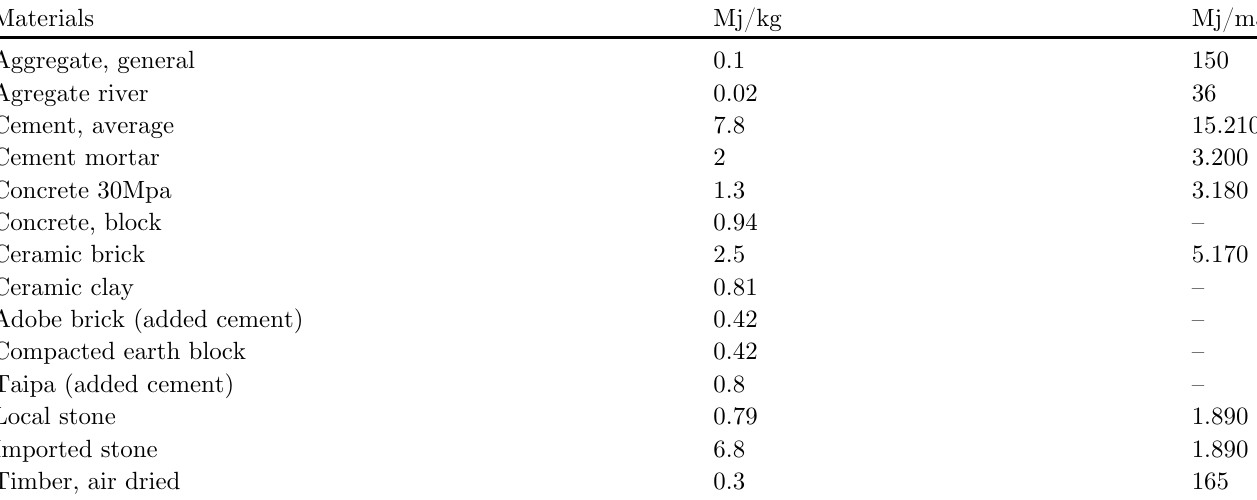
Table 2. Table of embodied energy coef fi cients of materials considered in Table 1. Center for Building Performance. WELLINGTON, U. of